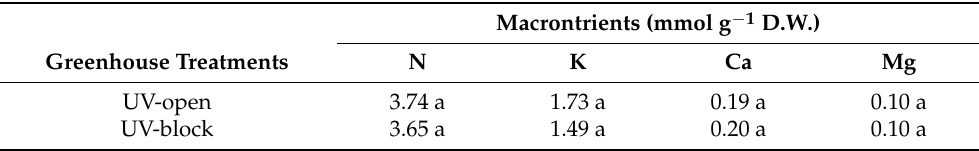
Table 5. Concentrations (mmol g − 1 dry weight) of total N, K, Ca, and Mg leaves of red lettuce (Redino Lollo rosso) as influenced by the greenhouse cover 42 days after transplanting.